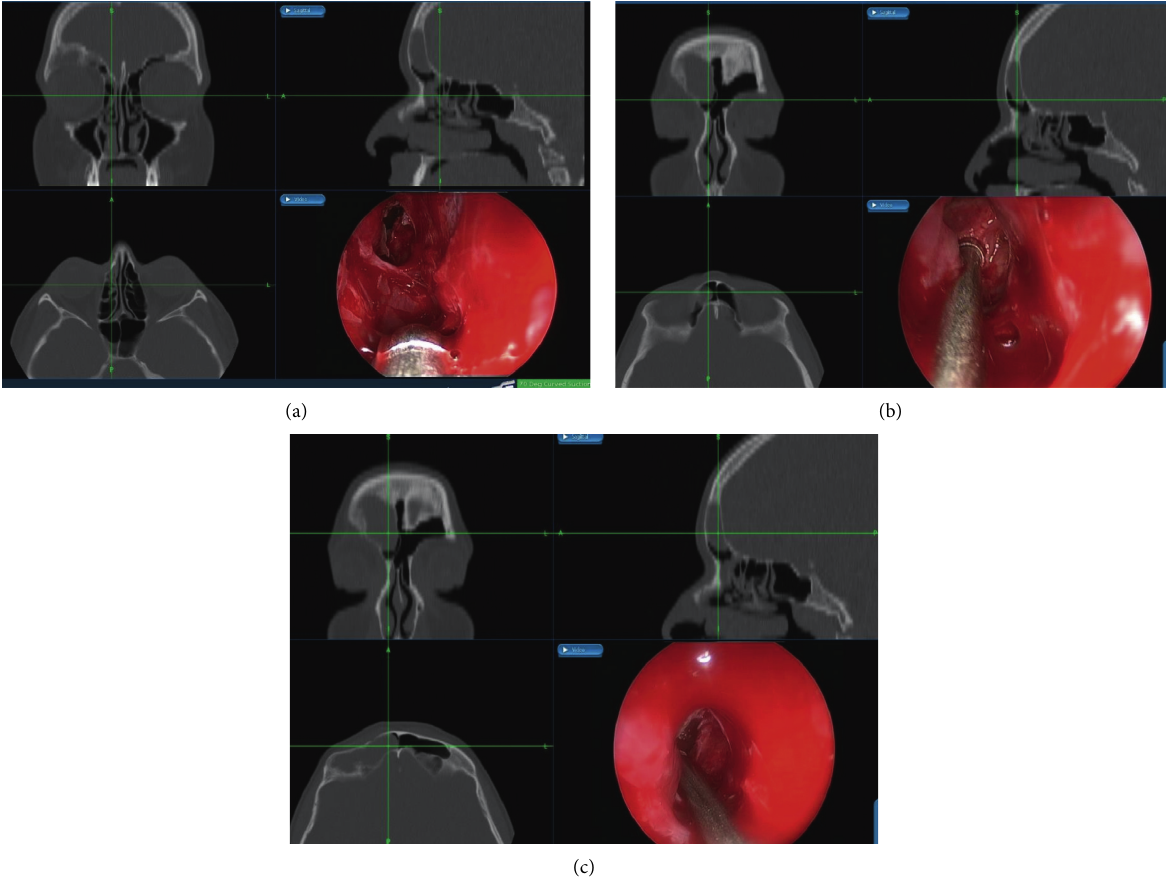
Figure 3: Endoscopic approach to frontal mucocele: Draf IIa wide frontal sinusotomy (a), 45-angled endoscopic view of the mucocele (b), and image-guided wide marsupialization of